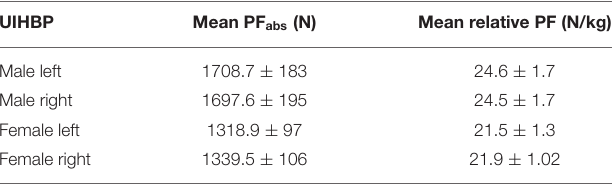
TABLE 2 | Descriptive statistics for unilateral isometric hex bar pull outcome